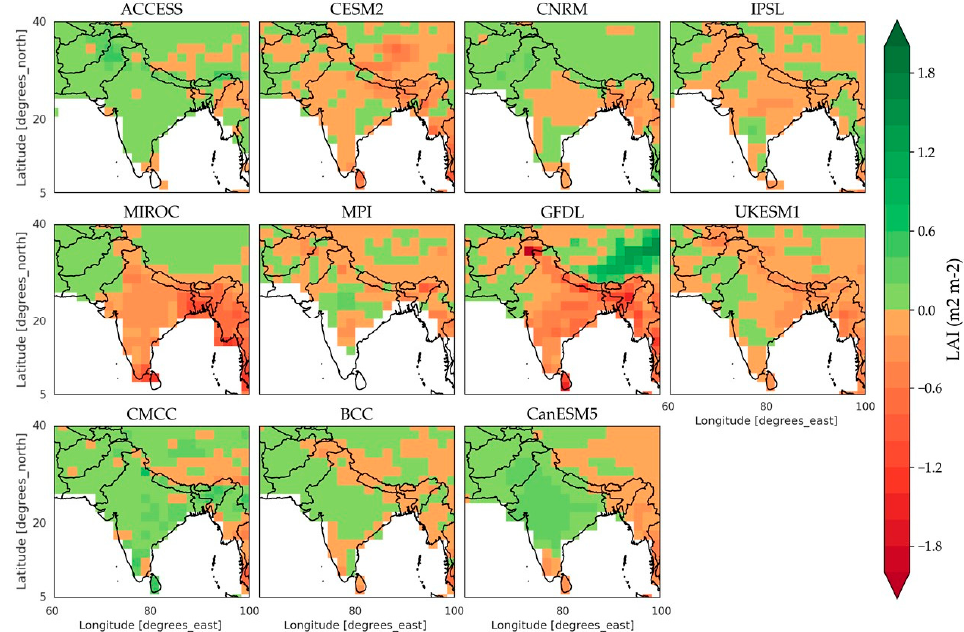
Figure 6. Spatial distribution of LAI changes ( historical — hist-noLu ) for each individual model. The color code follows the same logic as in Figure 3.